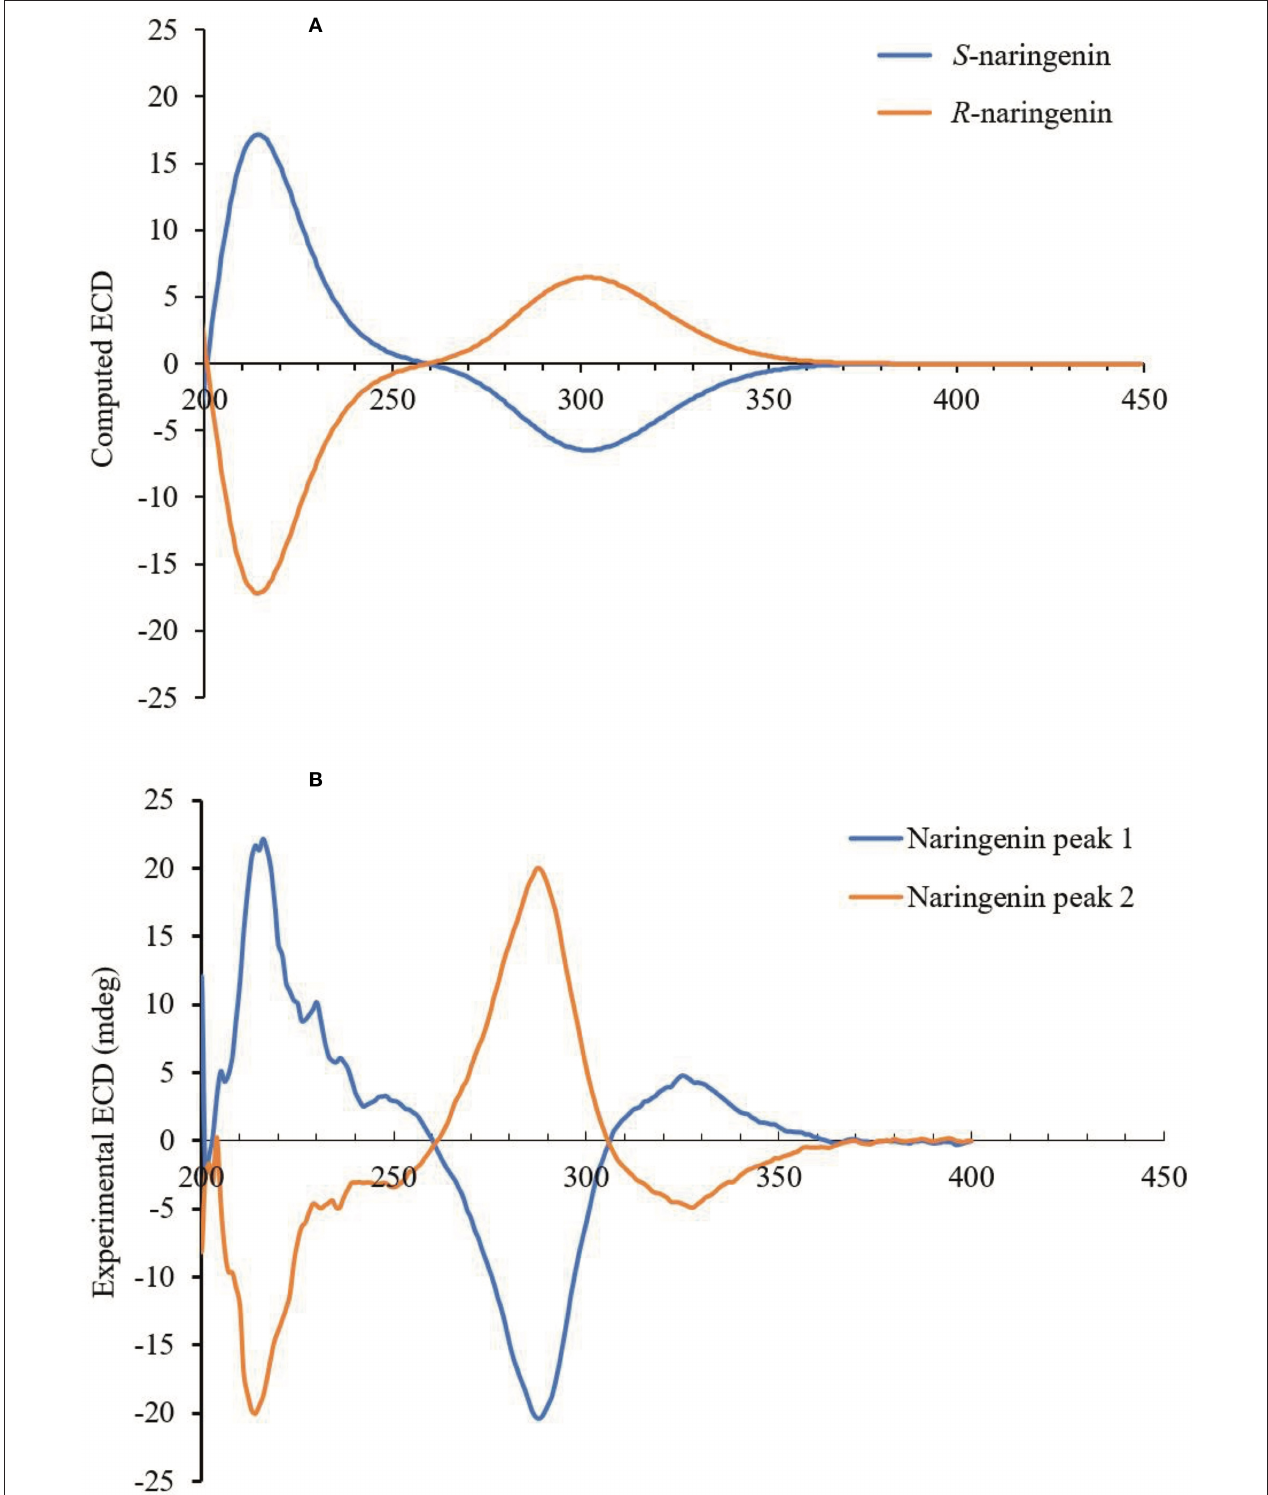
FIGURE 4 | (A) Predicted ECD spectra of naringenin enantiomers. (B) Experimentally measured ECD spectra of naringenin enantiomers in acetonitrile (150 mg/L).